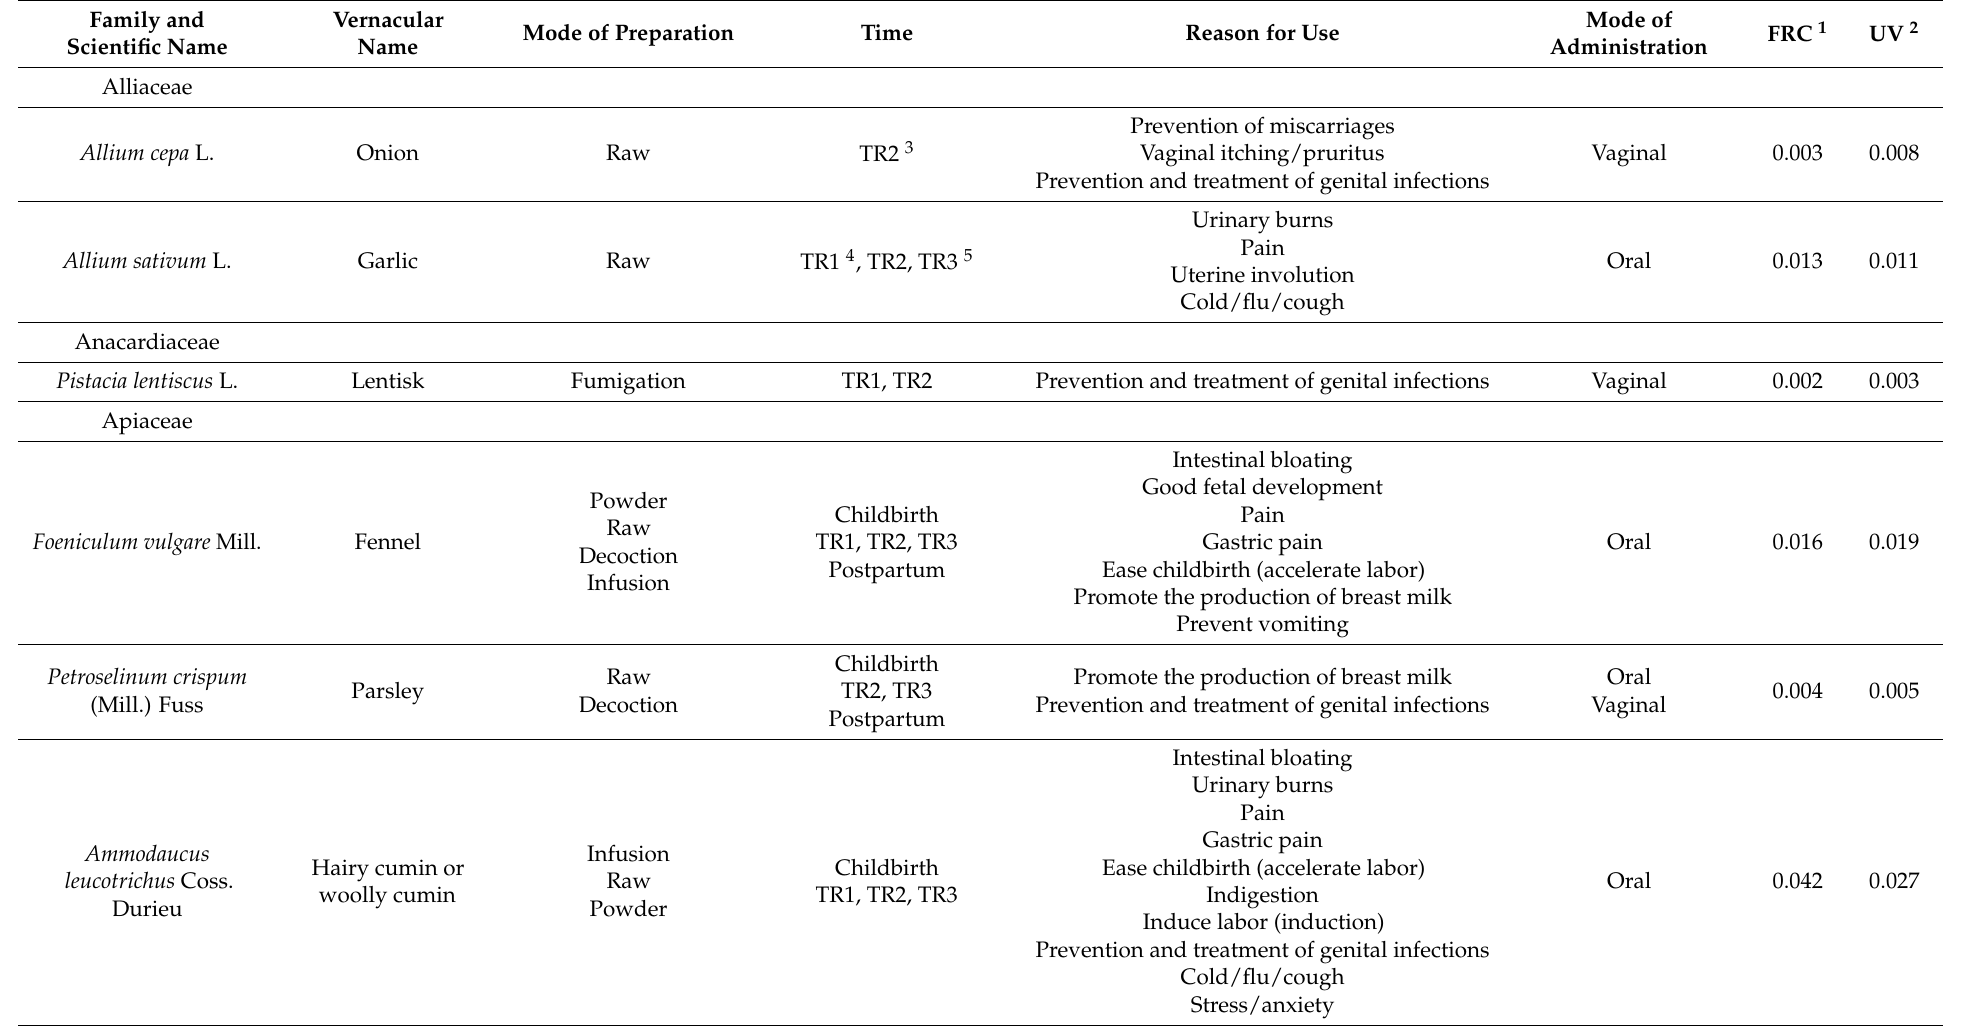
Table 3. List of medicinal plants used by pregnant women in the province of Guelmim during pregnancy, childbirth and at